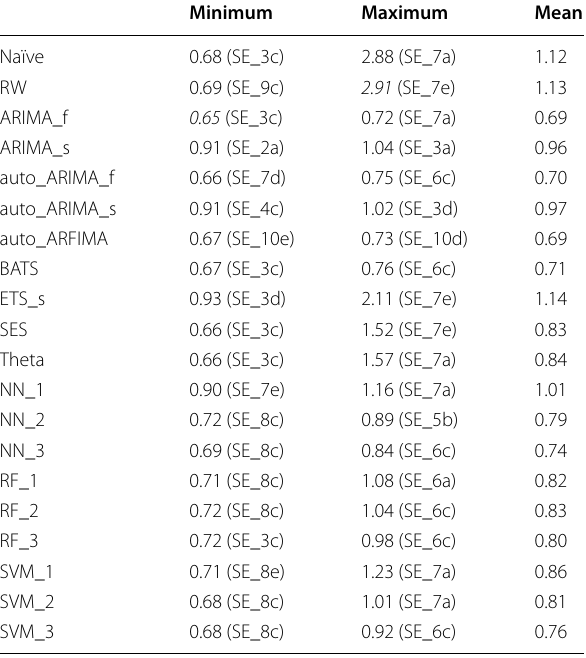
Table 17 Minimum, maximum and mean values of the MdoAE for each method within the simulation experi- ments